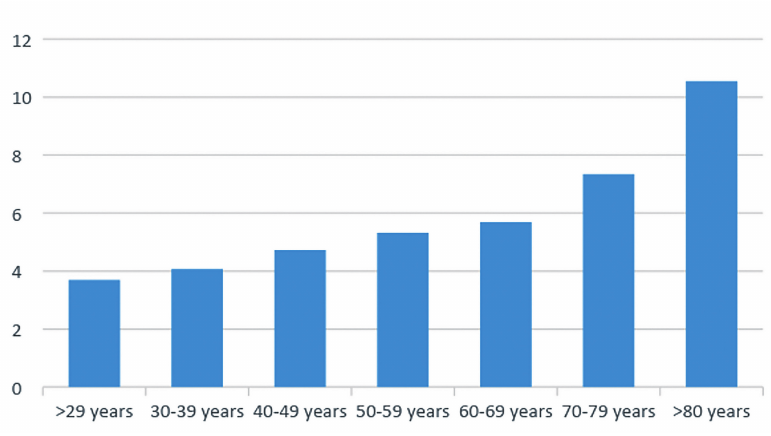
Figure 5 - Bladder Cancer Mortality during hospitalization according to age